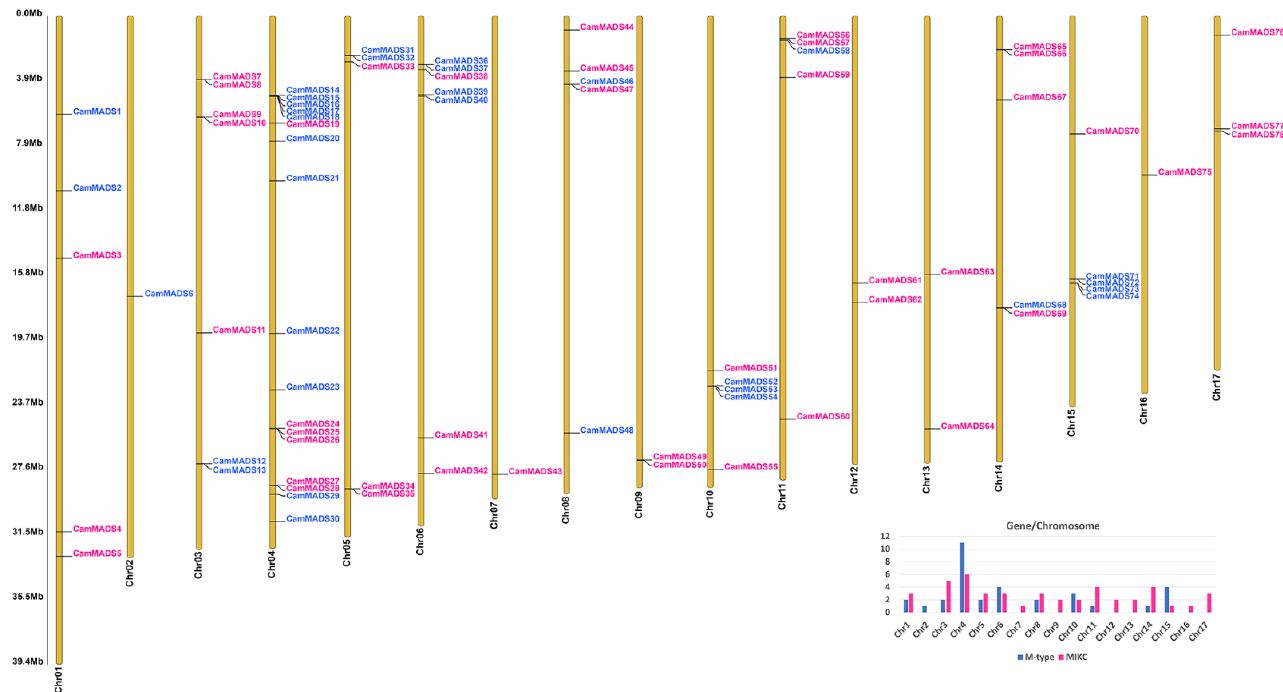
Figure 1. Chromosomal localization of the seventy-eight C. americana MADS-box genes. The number of each chromosome is given under the lines, blue indicates M-type genes, and pink indicates MIKC-type. The right side of each chromosome is related to the approximate physical location of each MADS-box gene. Bottom right: a plot of the number and type of CamMADS genes per chromosome.